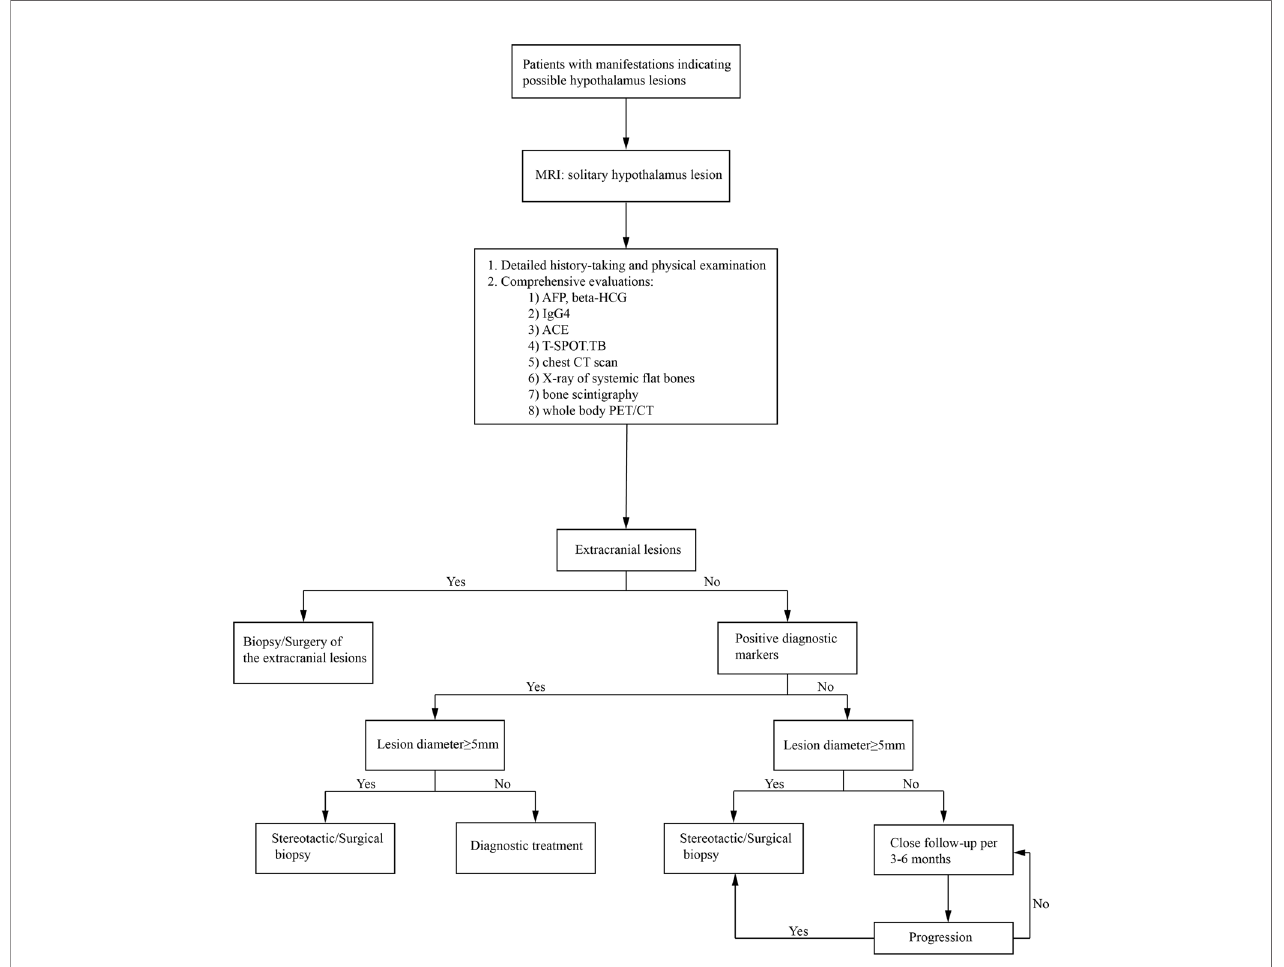
FIGURE 7 | An algorithm of the diagnosis of an intracranial solitary hypothalamus lesion. MRI, magnetic resonance imaging; ACE, angiotensin-converting enzyme; T-SPOT.TB, T-cell spot of tuberculosis test; CT, computed tomography; PET/CT, Positron emission tomography-computed